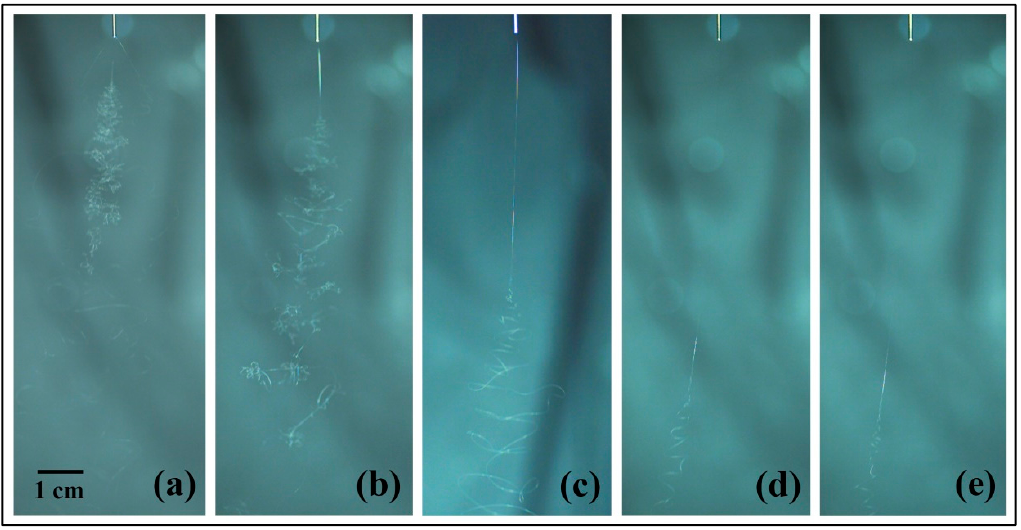
Figure 4. Jet trajectories captured by high-speed photography at different solution concentrations: ( a ) 10 wt %; ( b ) 15 wt %; ( c ) 20 wt %; ( d ) 25 wt %; and ( e ) 30 wt %. The electrospinning processing parameters were as follows: Applied voltage of 20 kV, working distance of 20 cm, and flow rate of 1.0 mL/h.